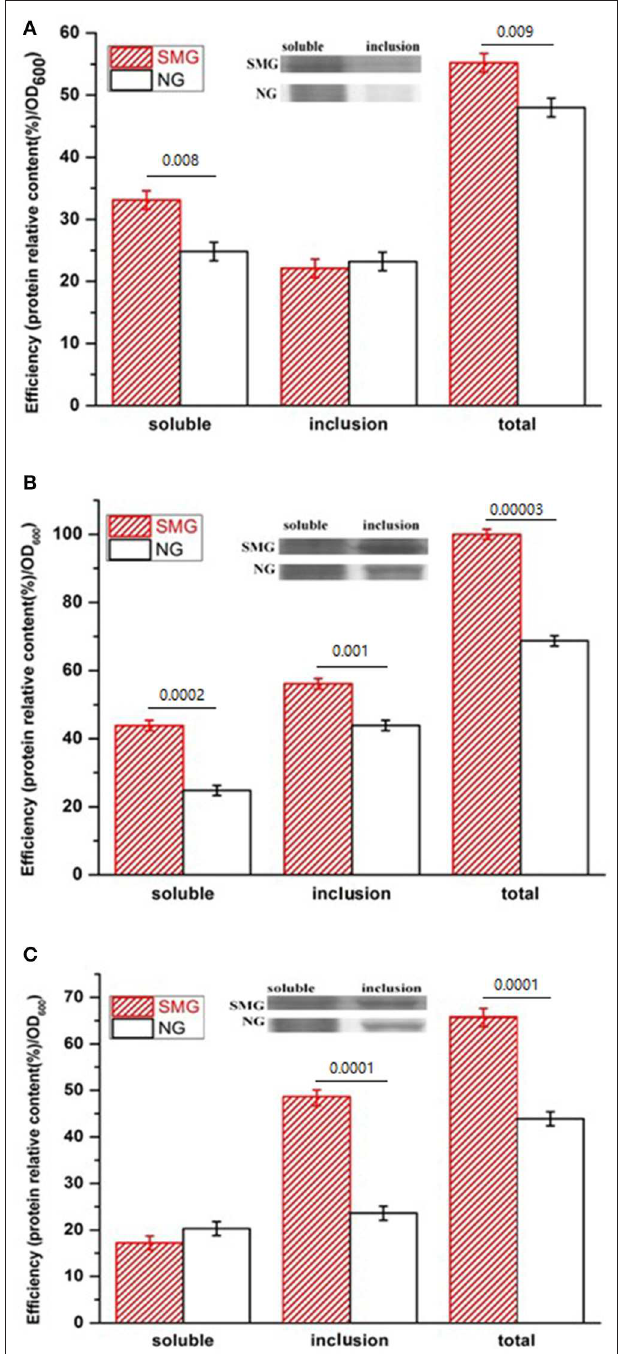
FIGURE 2 | Concentration and activity of the recombinant pGUS expressed under SMG and NG at different temperatures. (A) 17 ◦ C, (B) 27 ◦ C, and (C) 37 ◦ C. Significance was assessed using two-sided, paired Student’s t- test, and P -values are indicated as numbers in the graphs, n =